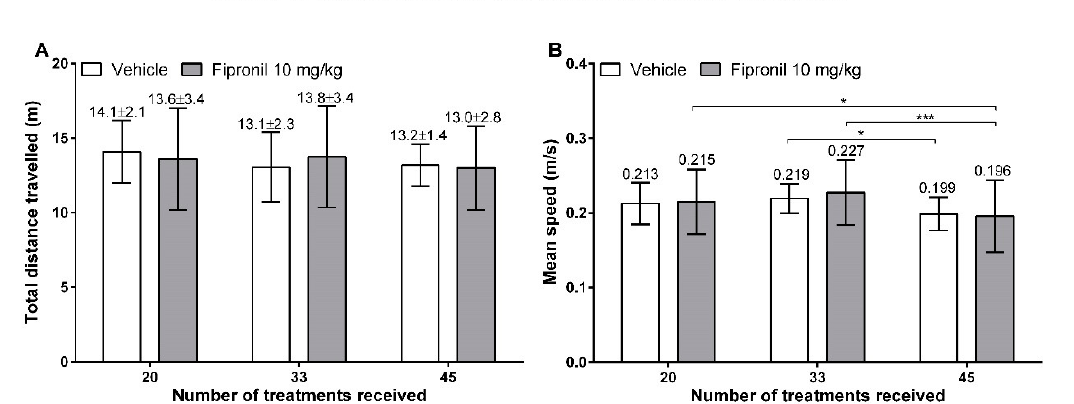
Figure 7. Velocity parameters measured during the Morris water maze task. ( A ) Total distance travelled during the probe trial in meters (Y axis) in function of the number of treatments (X axis). Mean values ± SD are indicated above the bars. ( B ) Mean speed as an average of the mean speed displayed during the training phase and the probe trial in meters travelled per second (Y axis) in function of the number of treatments (X axis). Mean values are indicated above the bars. The number of treatments received (corresponding to study duration) had a significant effect on the mean speed displayed by animals (Two-way RM ANOVA, p < 0.0001). *: p ≤ 0.05; ***: p ≤ 0.001.